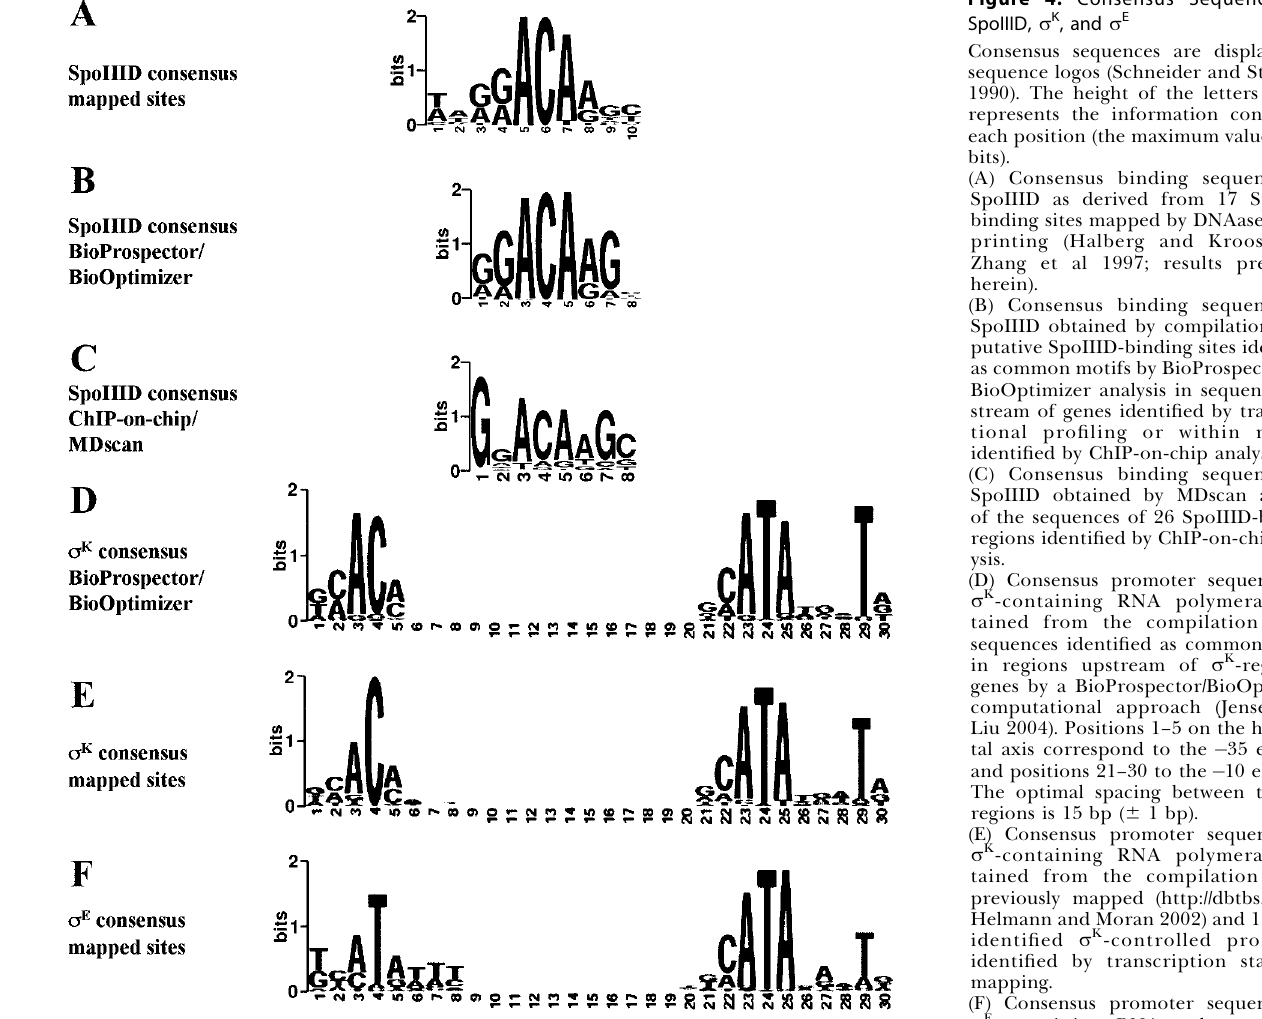
Figure 4. Consensus Sequences for SpoIIID, r K , and r E Consensus sequences are displayed as sequence logos (Schneider and Stephens 1990). The height of the letters in bits represents the information content at each position (the maximum value is two